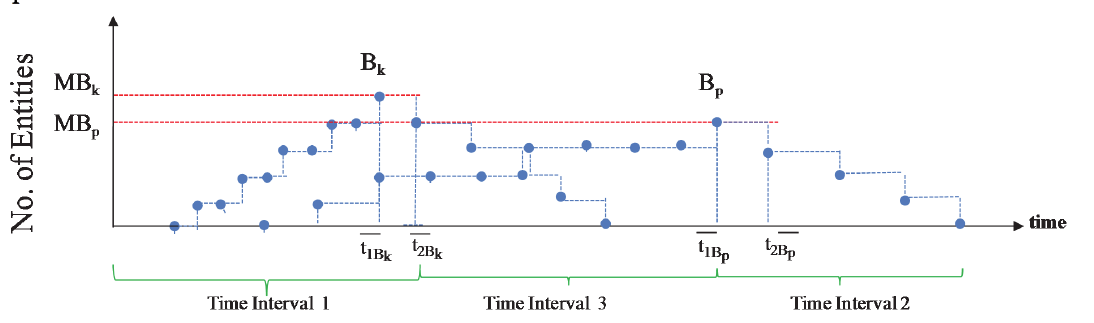
Fig. 9. Buffer profiles of B k and B p and time Intervals 1 through 3 for p = k +